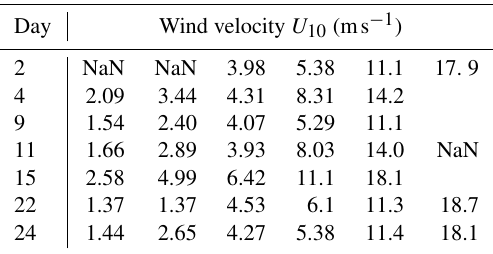
Table 1. Wind speed settings as applied during strategy I of the Aeolotron experiment; “NaN”: no values for U 10 .